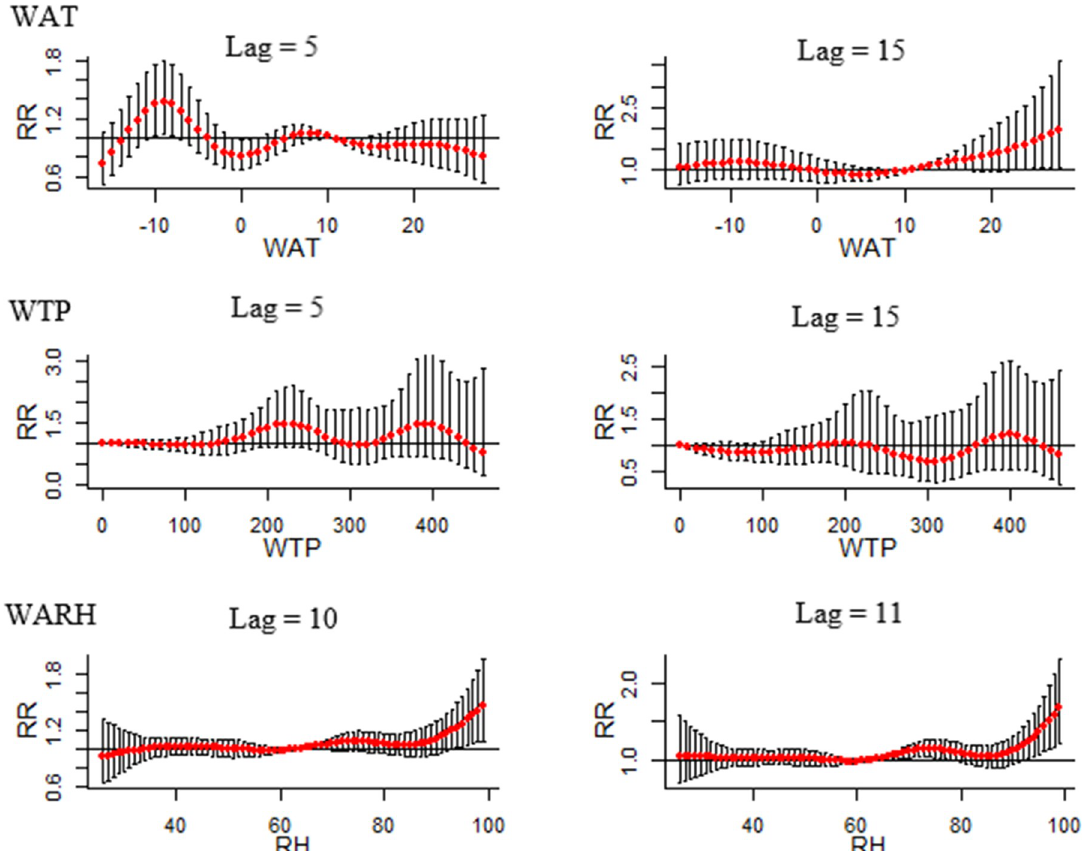
Fig 5. The lag-specific effect of climate factors on HFRS (Abbreviations: RR, relative risk; WAT, weekly average temperature; WTP, weekly total precipitation; WARH, weekly average relative humidity).